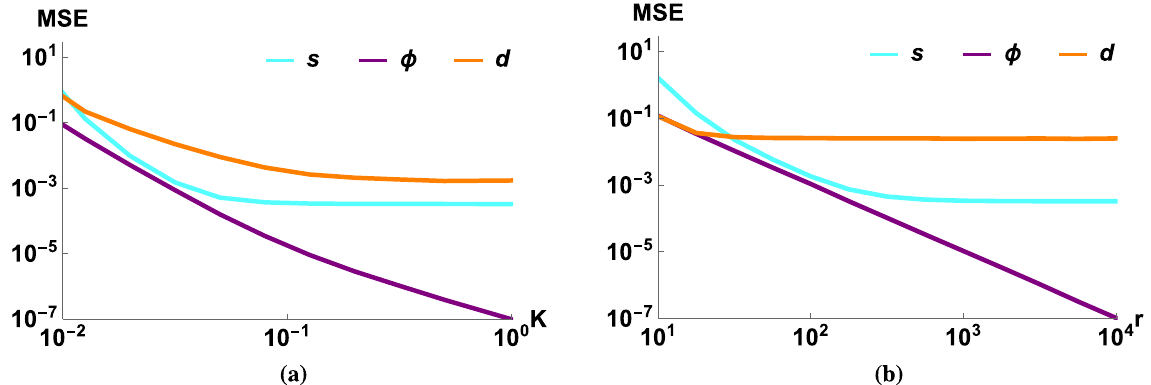
Figure 3. The MSE of the estimators of the Gaussian process as a function of ( a ) the transfer coefficient ( K ), and ( b ) the displacement of the light mode ( r ). The purple (dark) lines correspond to the phase shift, the orange (medium) lines correspond to the magnitude of the displacement and the cyan (light) lines correspond to the 3 10 5 , V 10 , T 0.99 , 1 10 V GP 10 4 , η magnitude of the squeezing. The parameters were N , V th − = = = − = = = 0.03 , d 0.05 , β 1.02 , α 0.6 , ( a ) r 10 2 , ( b ) K 0.03 0.4 , s (cid:31) = = = = − = = =